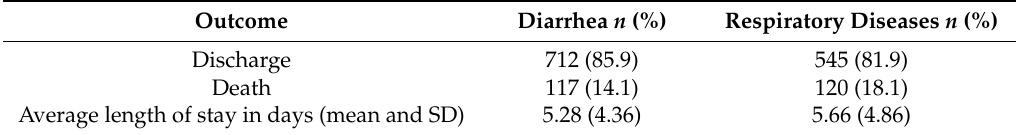
Table 3. Outcome of diarrhea and respiratory diseases and the average of hospitalization periods in children <5 years of